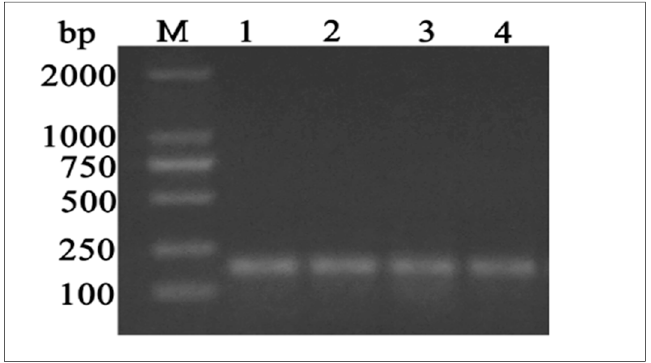
Figure 2. DNA gel electrophoresis of PCR products showing bands of MTHFR coding sequence in testes samples. M, marker, L1, L2, L3, and L4 stand for juvenile yak, juvenile yellow-cattle, adult yak, and adult yellow-cattle. bp: base pairs